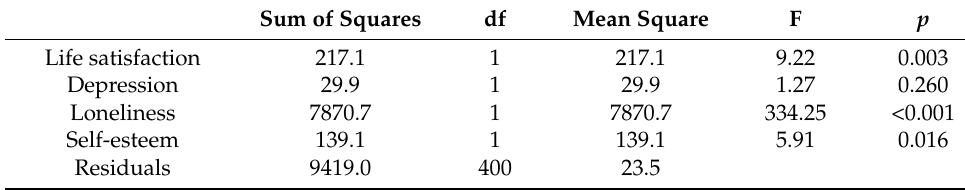
Table 6. Omnibus ANOVA